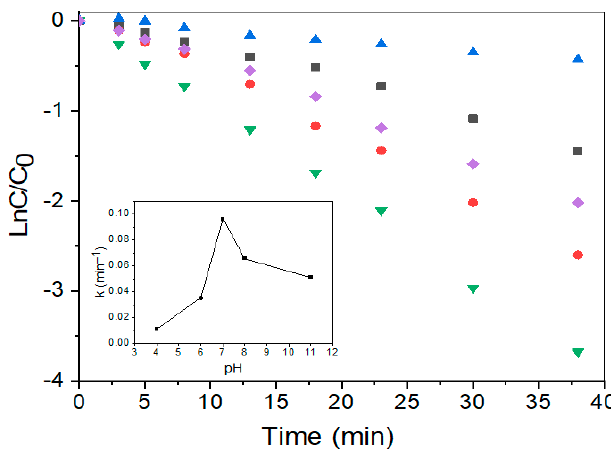
Figure 7. E ff ect of pH on the photocatalytic performance of Ag 3 PO 4 , (cid:78) : pH = 4, (cid:4) : pH = 6, (cid:72) : pH = 7, Figure 7. Effect of pH on the photocatalytic performance of Ag 3 PO 4 , ▲ : pH = 4,  : pH = 6, ▼ : pH = • : pH = 8, Figure 6. Loss of QY (20 ppm) in the absence of Ag Figure 7. Effect of pH on the photocatalytic performance of Ag 3 PO 4 , ▲ : pH = 4,  : pH = 6, ▼ : pH = : pH = 11. Insert: Rate constants vs. pH ([QY] 0 = 20 ppm and Ag 3 PO 4 dose = 0.5 g · L − 1 7,  : pH = 8,  : pH = 11. Insert: Rate constants vs. pH ([QY] 0 = 20 ppm and Ag 3 PO 4 dose = 0.5 g·L − 1 ). 3 PO 4 under visible light ( ▲ ) or UVA (  ), in the 7,  : pH = 8,  : pH = 11. Insert: Rate constants vs. pH ([QY] 0 = 20 ppm and Ag 3 PO 4 dose = 0.5 g·L- 1 ). presence of Ag 3 PO 4 in the dark ( ▼ ), upon UVA irradiation (  ) or upon visible light (  ). ([QY] 0 = 20 ppm, Ag 3 PO 4 dose = 0.5 g·L − 1 and pH~7).